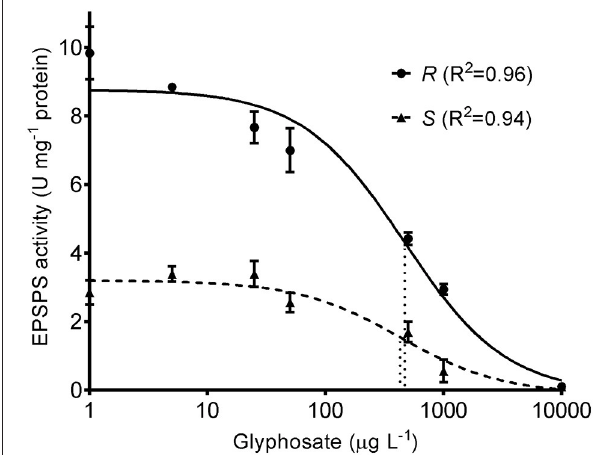
represent mean values and the vertical bars are ± 1 standard error of the mean. The curves represent predicted responses and dotted lines indicate I50 for each